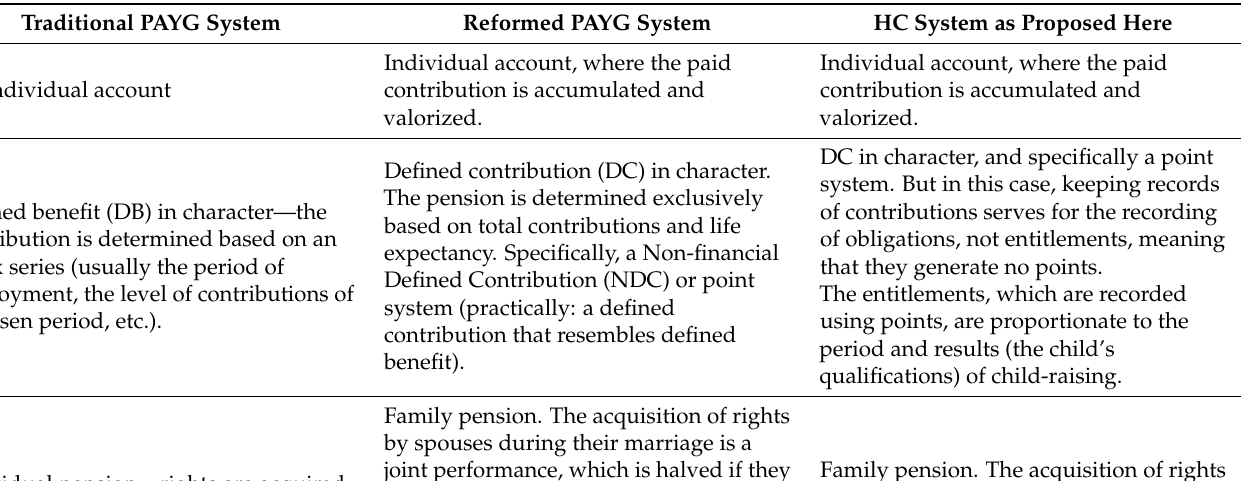
Table 2. The specialties of the HC system I am proposing in this paper, which would also be worthwhile introducing in traditional PAYG